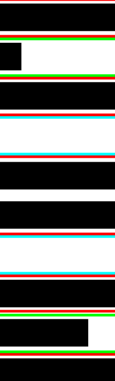
Figure 10. Process of piece clustering in area 1.